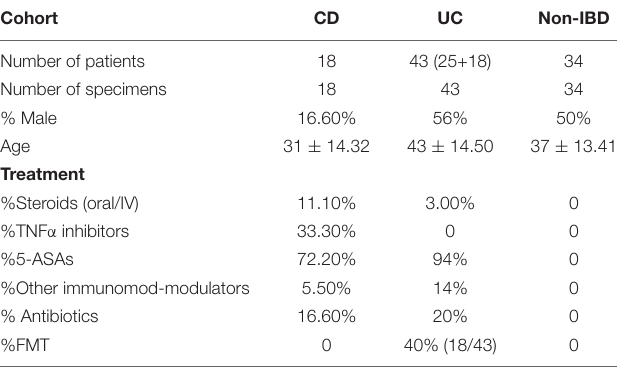
TABLE 1 | Basic characteristics of healthy controls and IBD